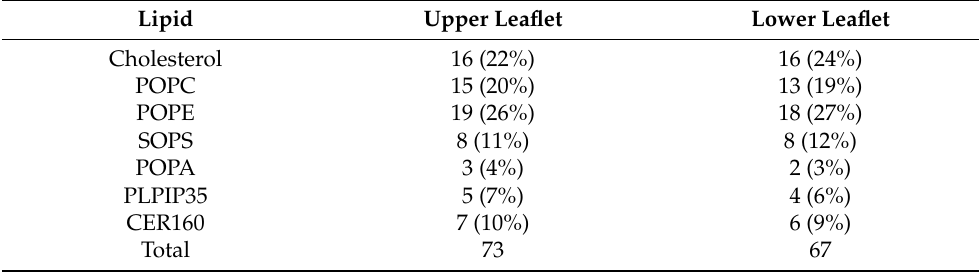
Table 2. Membrane composition for δ C1b-bryostatin and δ C1b-Merle27 simulations. Lipid Upper Leaflet Lower